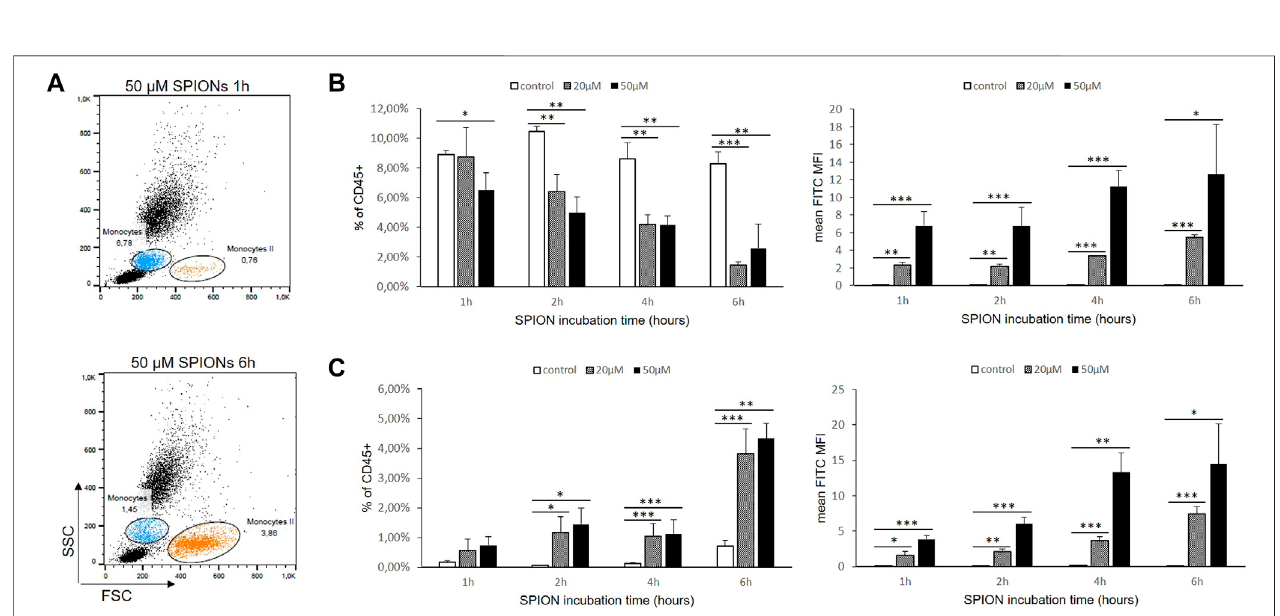
FIGURE6| SPIONuptakebyprimarymonocytesinwholeblood. (A) DotBlotsofFACSanalysesfromonerepresentativesampleafter1and6 hSPIONincubation. Regular monocytes (Monocytes I) are colored in blue and larger-sized monocytes (Monocytes II) are colored in orange. (B) Percentage of Monocytes I and their FITC fl uorescence (MFI) in SPION-incubated cultures over time. (C) Percentage of Monocytes II and their FITC fl uorescence (MFI) in SPION-incubated cultures over time. Signi fi cance: student`s t -Test. * p ≤ 0.05; ** p ≤ 0.01; *** p ≤ 0.001. n = 3.